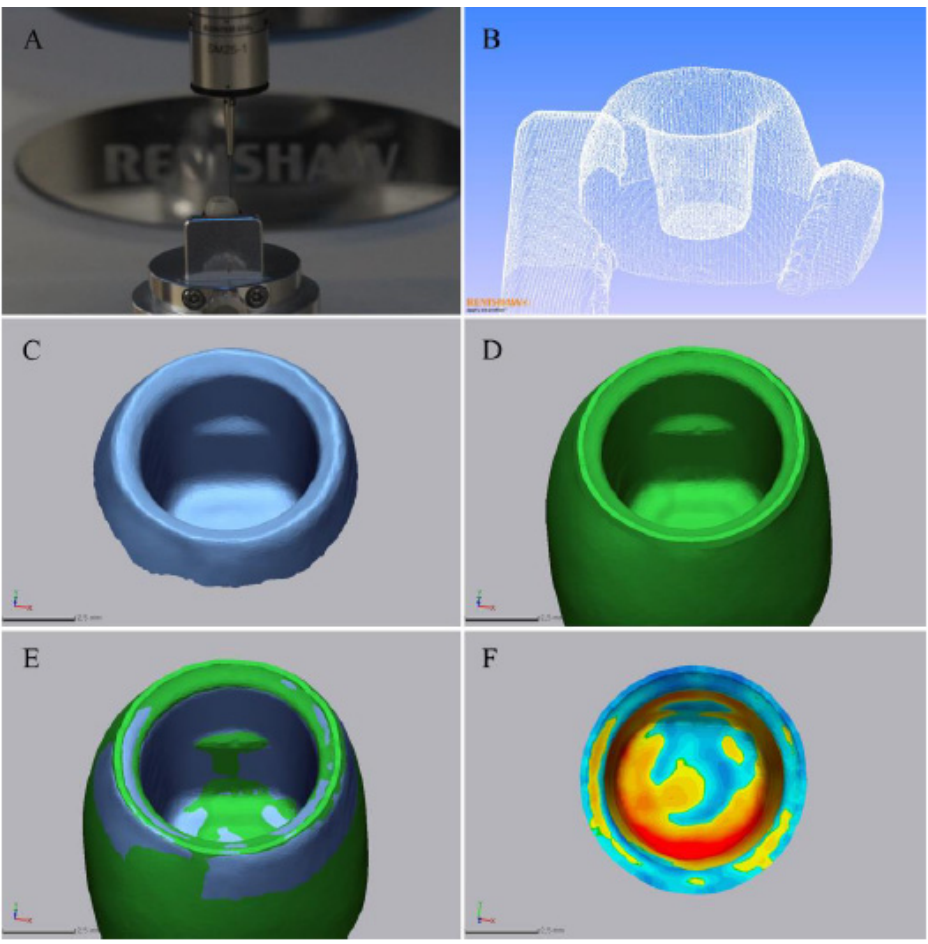
Figure 2. Procedure for evaluating trueness. ( A ) The contact scanning procedure. ( B ) A 3D modeling result of contact scanning. ( C ) A crown scanned model (CSM). ( D ) A crown designed model (CDM). ( E ) A CSM and CDM superimposed. ( F ) A color di ff erence